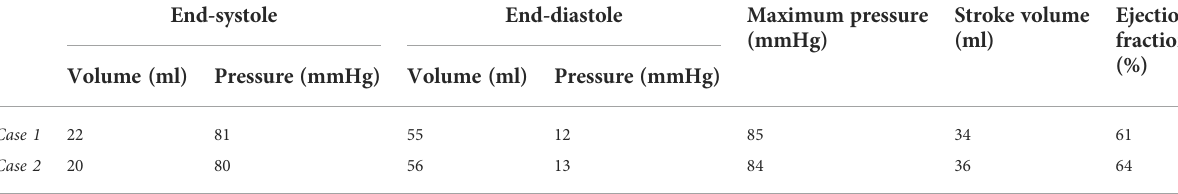
TABLE 1 Pressure and volume magnitudes of the healthy con fi guration before the HF induction.